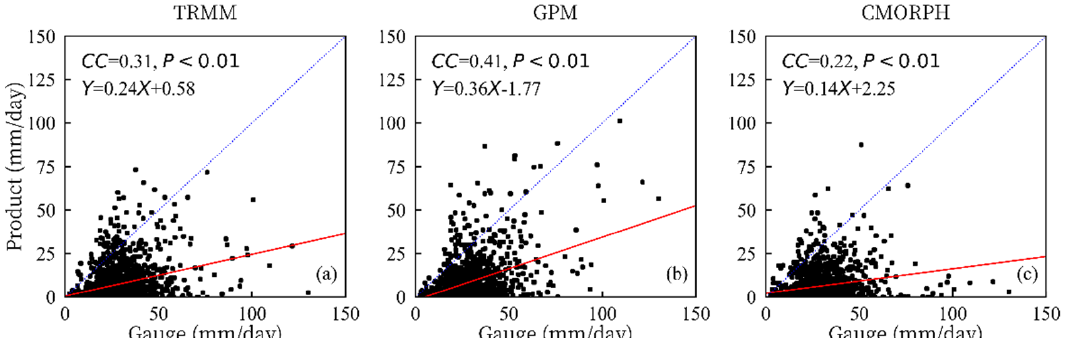
Figure 10. The scattered distribution diagrams of annual maximum daily precipitation between ( a ) TRMM, ( b ) GPM, ( c ) CMORPH and gauge. The red line and the blue dashed line represent the linear fitted line and the 1:1 line, respectively.